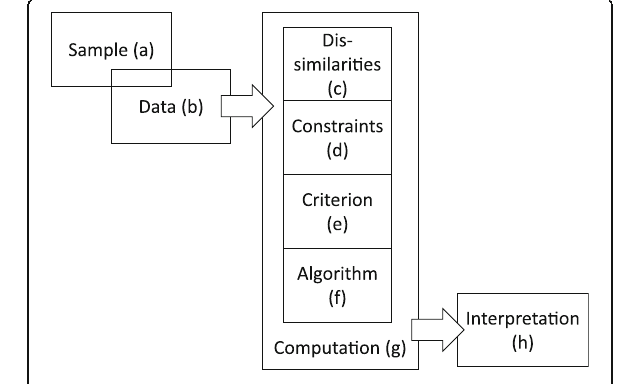
Fig. 5 Process of the cluster analysis